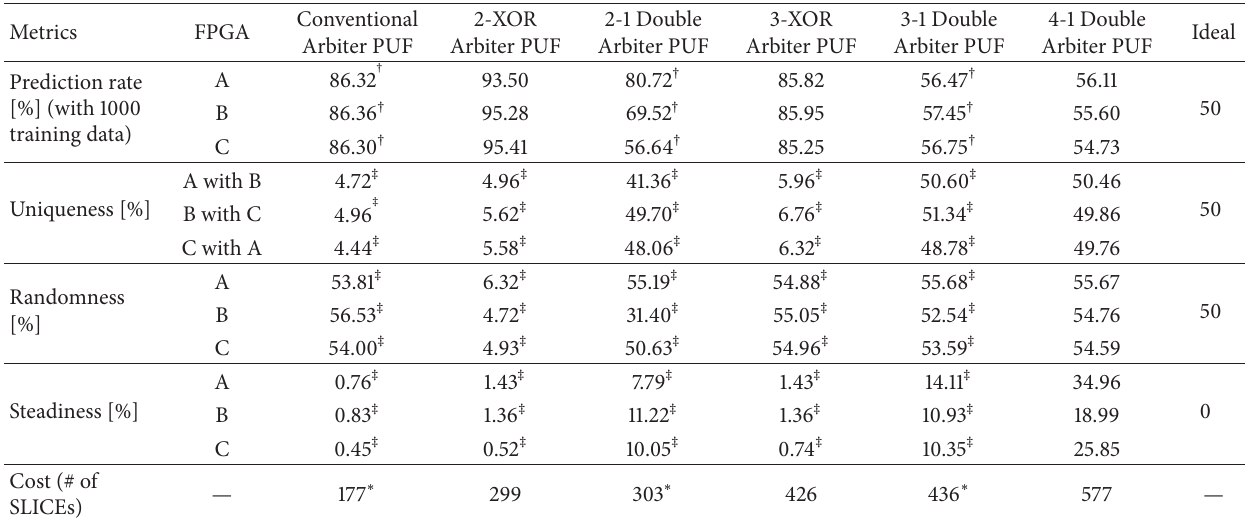
Table 4: Results of the overall evaluation.